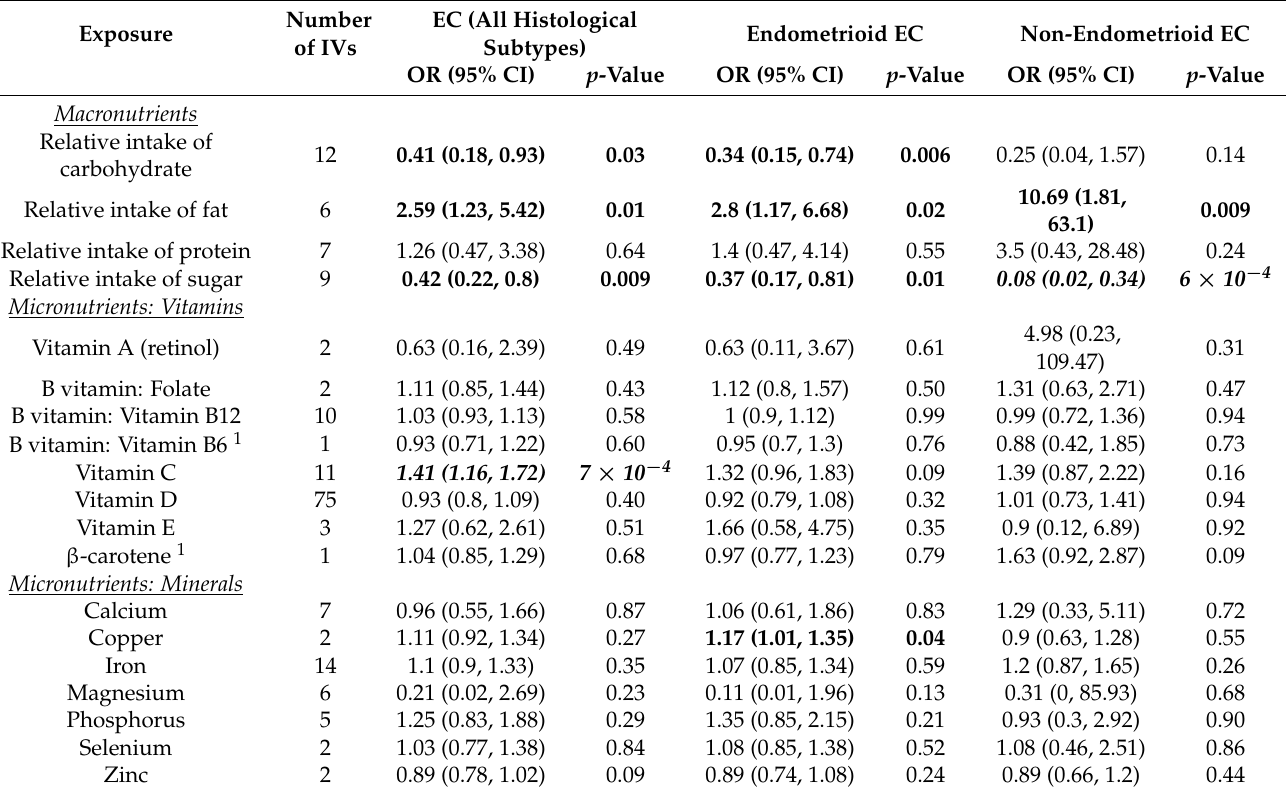
Table 2. Inverse variance weighted Mendelian randomization results for dietary factors by endome- trial cancer histological